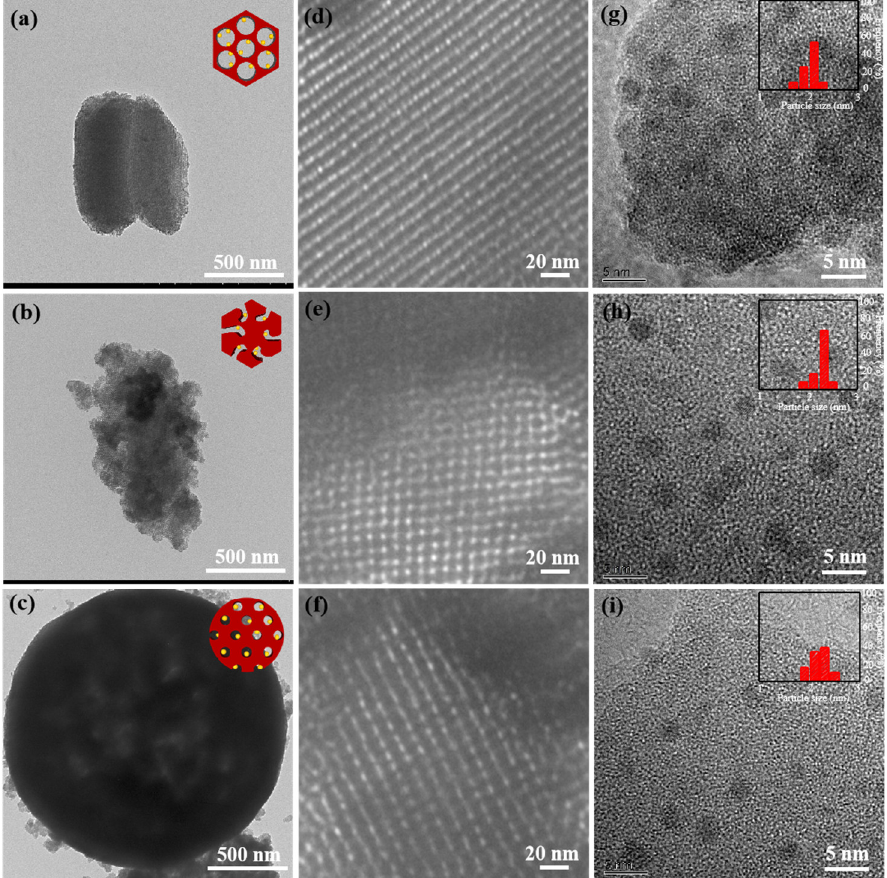
Figure 3. TEM images and particle size distributions of Cu nanoparticles over Cu/SBA-15, Cu/KIT-6, and Cu/HMS catalysts. ( a – c ) The morphologies of the catalysts; ( d – f ) the pore sizes of the catalysts; ( g – i ) the Cu nanoparticle sizes of the catalysts.